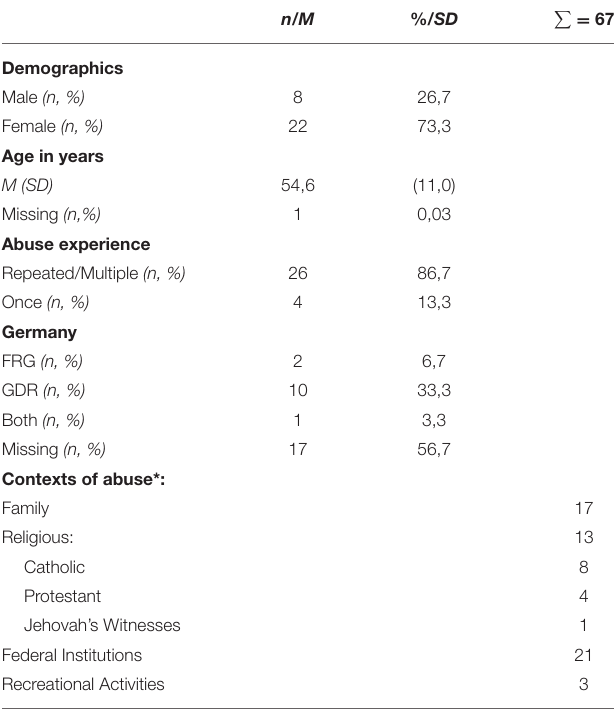
TABLE 1 | Descriptive data: demographics and contexts of abuse ( N = 30).